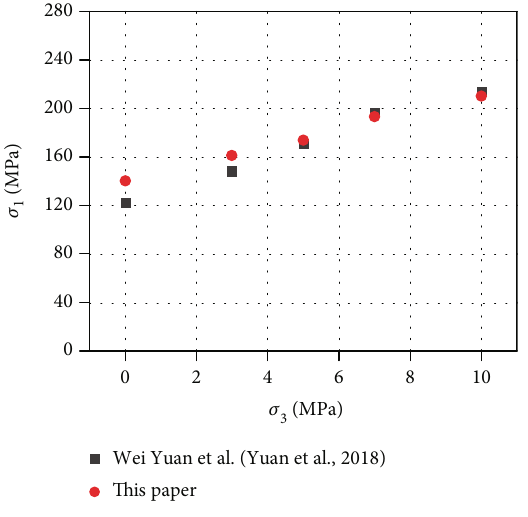
Figure 7: Comparison of biaxial compression test of sandstone